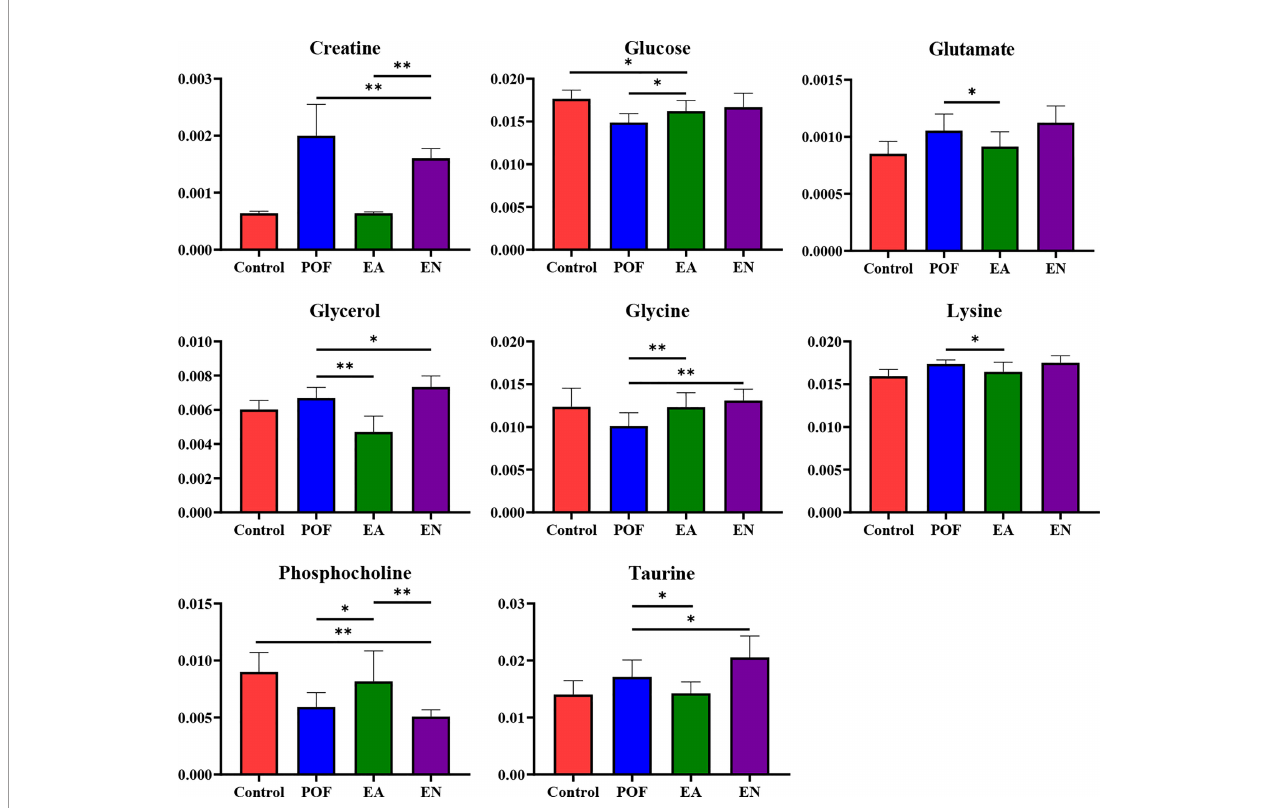
FIGURE 8 | The relative concentrations of characteristic metabolites in the liver (* means P < 0.05; ** means P <